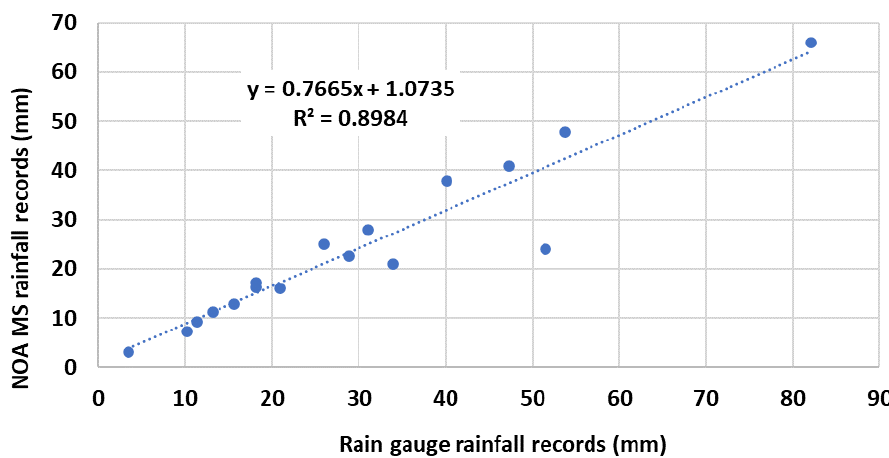
Figure 5. Scatter plot of the recorded rainfall events. Correlation between the automate NOA MS and the daily data from the installed rain gauge.